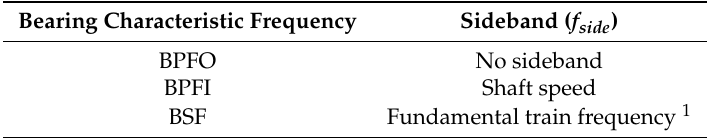
Table 1. The specification of the target bearing, FAG NJ206-E-TVP2.